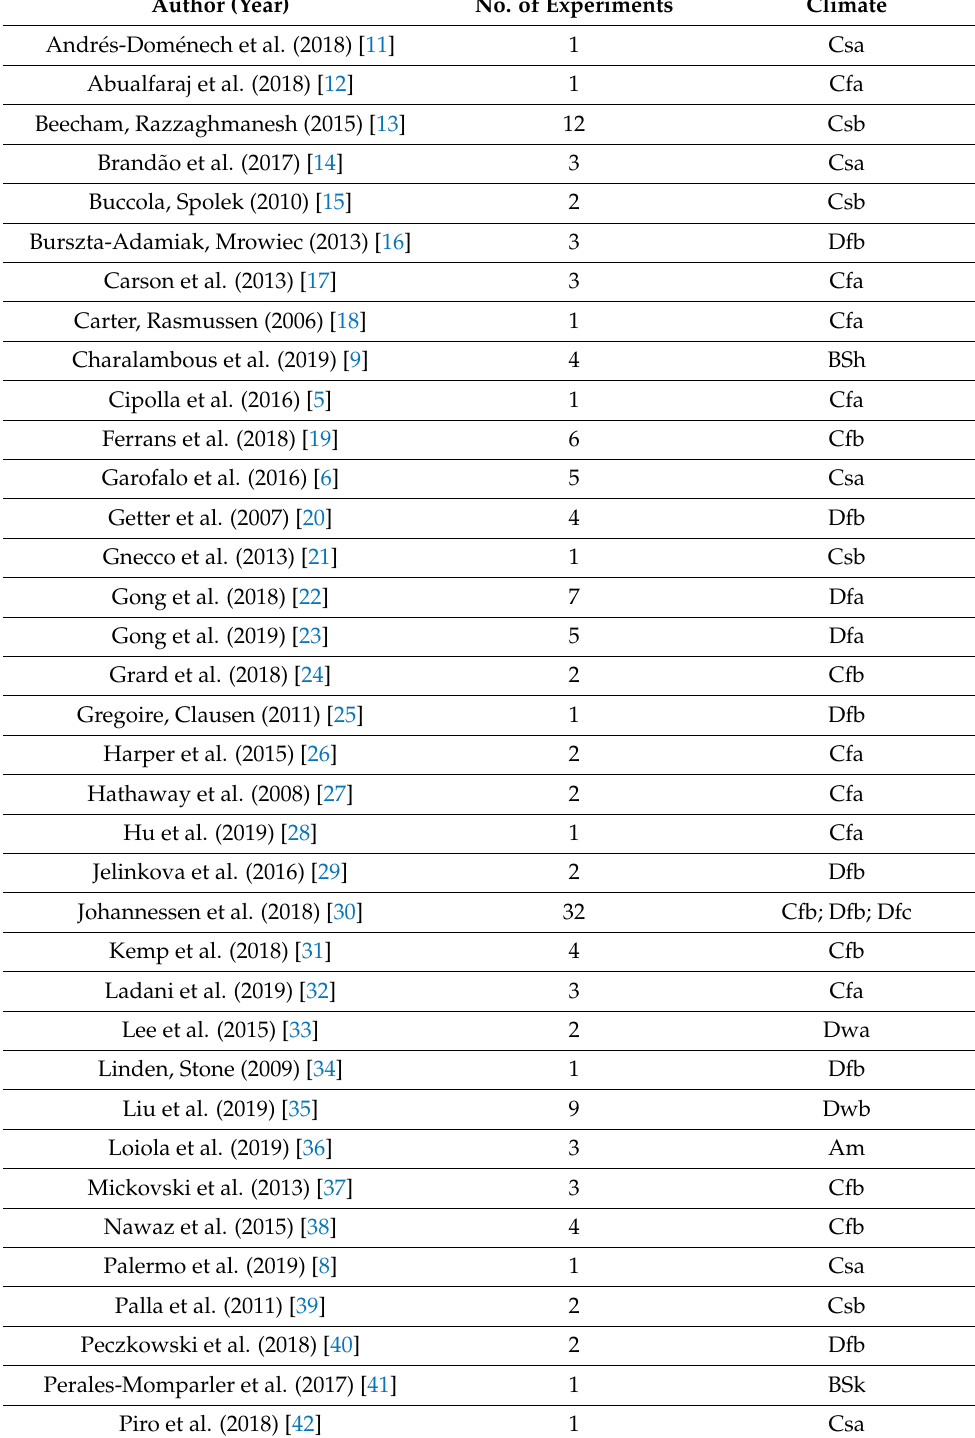
Table 1. Articles describing the hydrological behavior of green roofs, with number of experiments by article and corresponding